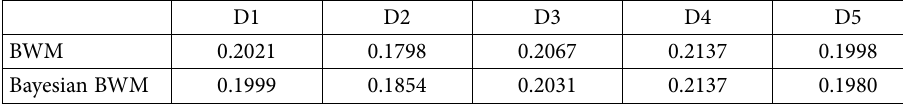
Table 6. System related